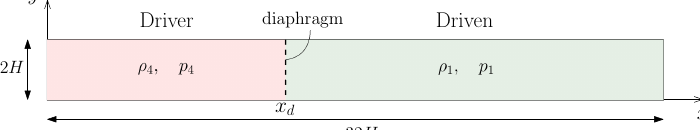
Figure 2. The sketch of the viscous shock-channel of Zeitoun et al. [21] for microfluidic